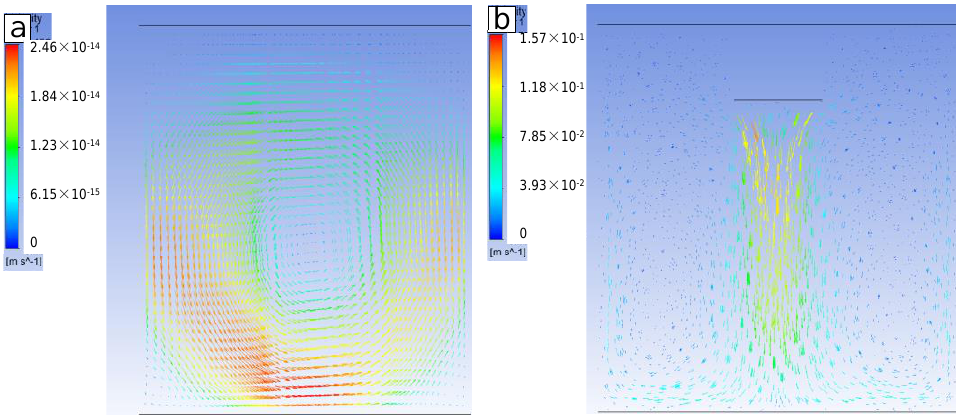
Figure 10. Flow patterns and velocity of the melts under ( a ) no ultrasonication and ( b ) ultrasonication.